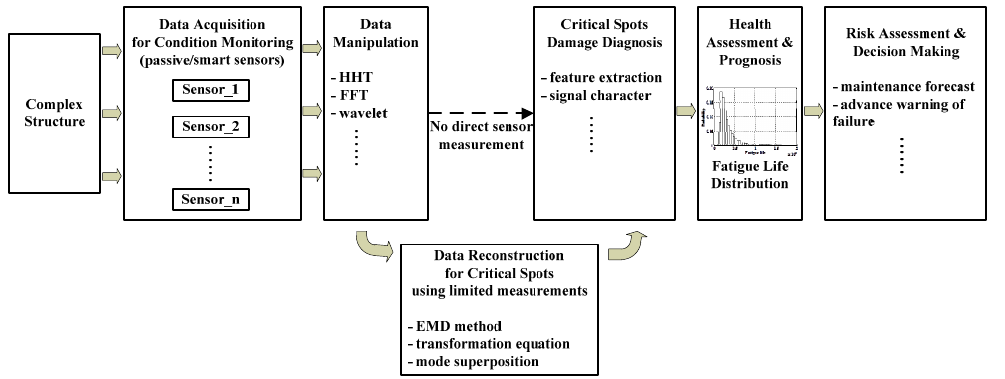
Figure 1. Overall procedure of the fatigue life evaluation method.